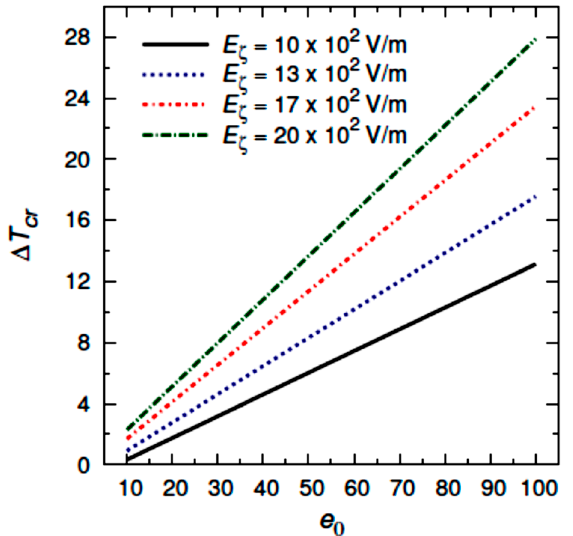
Figure 9. Effects of the piezoelectric multiple e 0 on the critical buckling temperature ∆ T cr of simply supported SGP annular plates for different values of electric field E ζ ( R o / h = 10, R i / R o = 0.3, κ = 1, Δ𝐶 = 0.5% , 𝑤 (cid:3034) = 0.1% , 𝐽 (cid:2869) = 10 (cid:2871) , 𝐽 (cid:2870) = 10 (cid:2870) ).